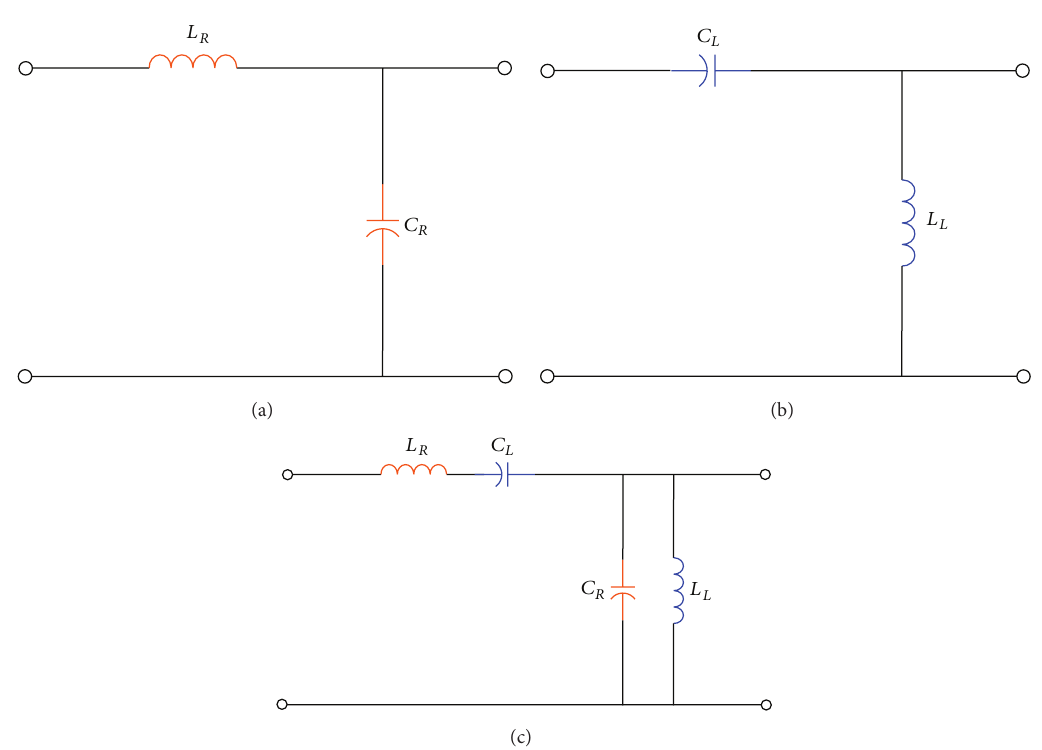
Figure 1: Equivalent circuits: (a) pure RH TL, (b) pure LH TL, and (c) CRLH